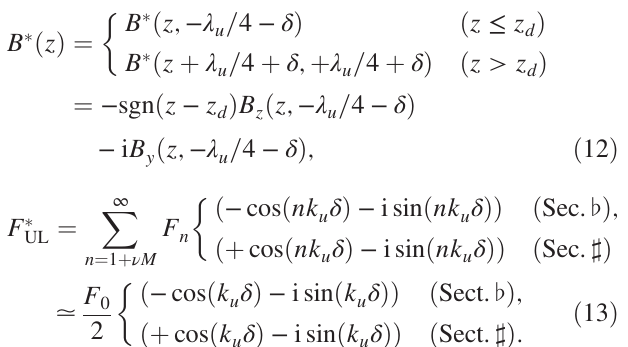
¼ − λ = 4 in the section, and u UL ¼ − λ = 4 as shown in (e) the phase u LU